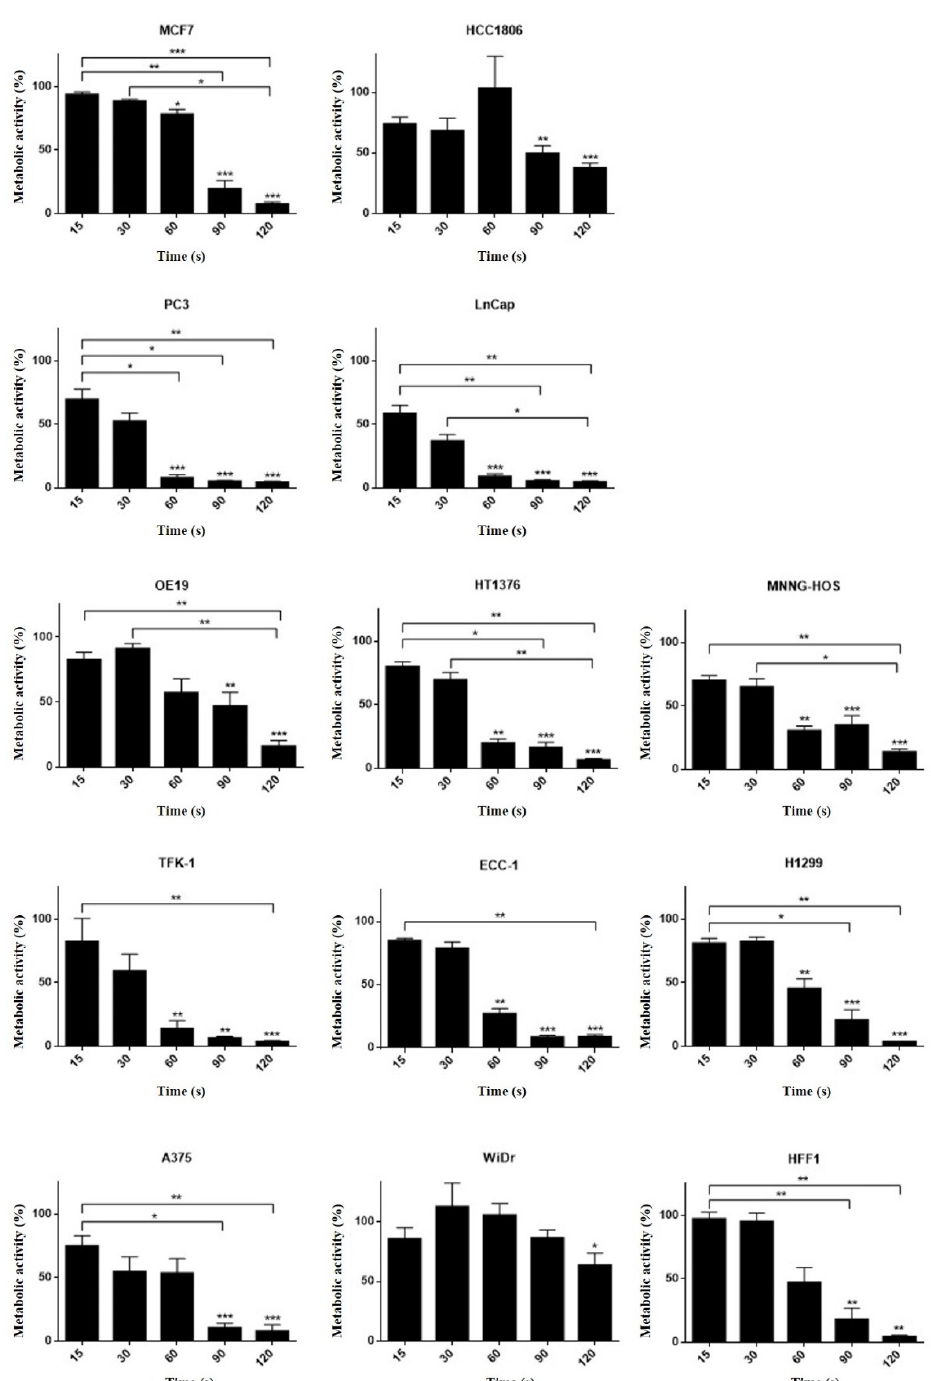
Figure A1. MTT assay results 24 h after plasma therapy application in different human cell lines: hormonal receptor positive breast cancer (MCF7), triple-negative breast cancer (HCC1806), prostate (PC3 and LnCap), esophageal adenocarcinoma (OE19), urinary bladder grade 3 carcinoma (HT1376), osteosarcoma (MNNG-HOS), extrahepatic bile duct carcinoma (TFK-1), endometrial cancer (ECC-1), lung cancer (H1299), melanoma (A375), colon carcinoma (WiDr), and fibroblast (HFF1) at distinct times: 15, 30, 60, 90, and 120 s. Results are expressed as the percentage of metabolic activity normalized to control. Statistical significance in relation to control and between cell populations is represented as * for p < 0.05, ** for p < 0.0,1 and *** for p < 0.001 ( n = 9).